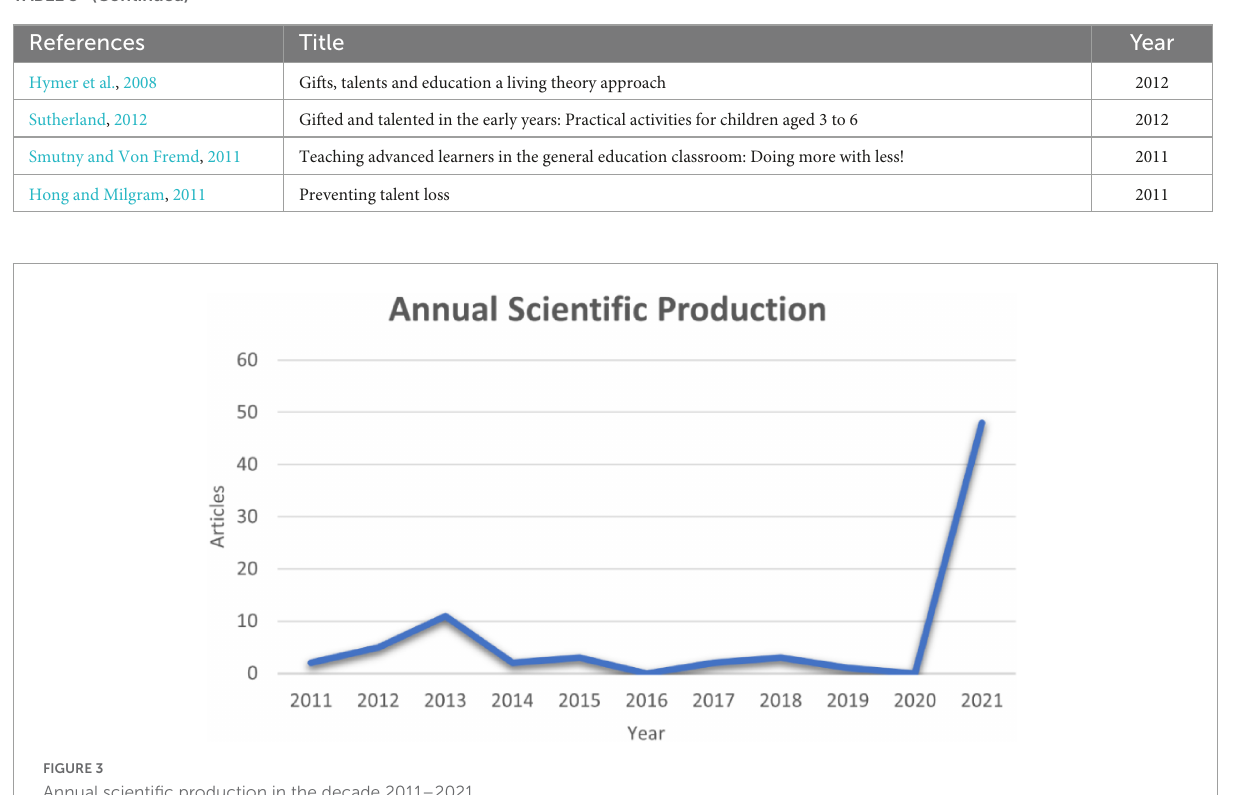
FIGURE3 Annual scientific production in the decade 2011–2021.